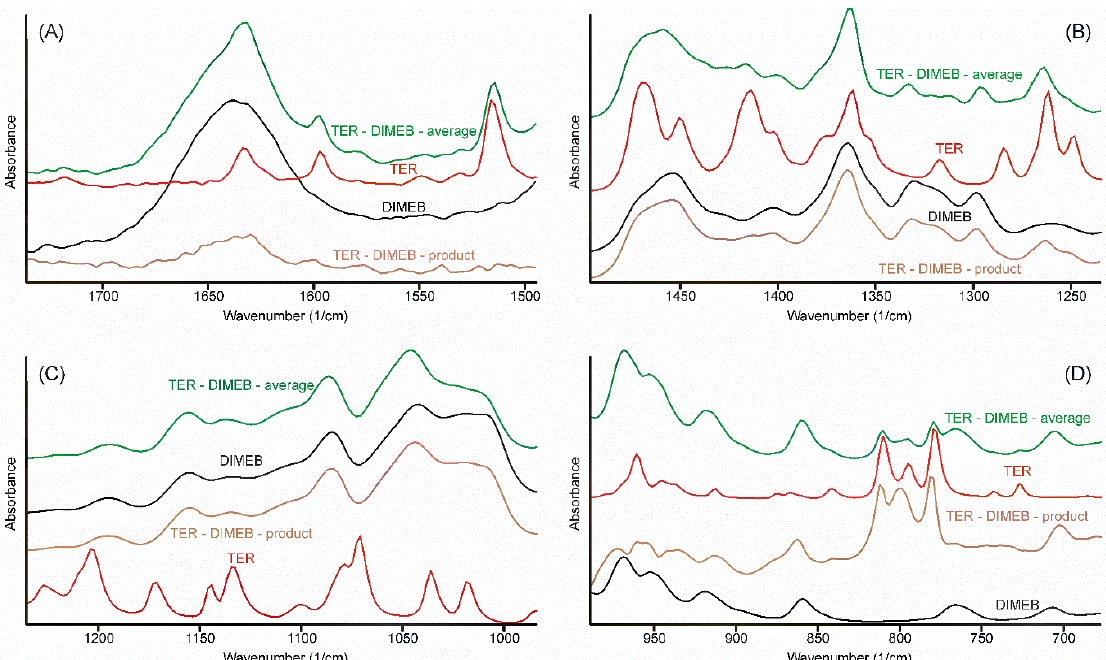
Figure 10. Construction of the FTIR spectrum (regions 1750–1495; 1495–1230; 1430–990; és 990–675 cm − 1 ( A – D ) respectively) of the product in the TER-DIMEB system, by successive subtraction of the spectra of the starting materials from the average spectrum of the samples taken at various times of the grinding process. The spectrum of the product resembled the spectrum of DIMEB. Only the out-of-plane deformation bands of TER can be seen at 809, 798, and 778 cm − 1 , somewhat shifted. All other bands of TER disappeared, including the tertiary ammonium band (not shown in the Figure).